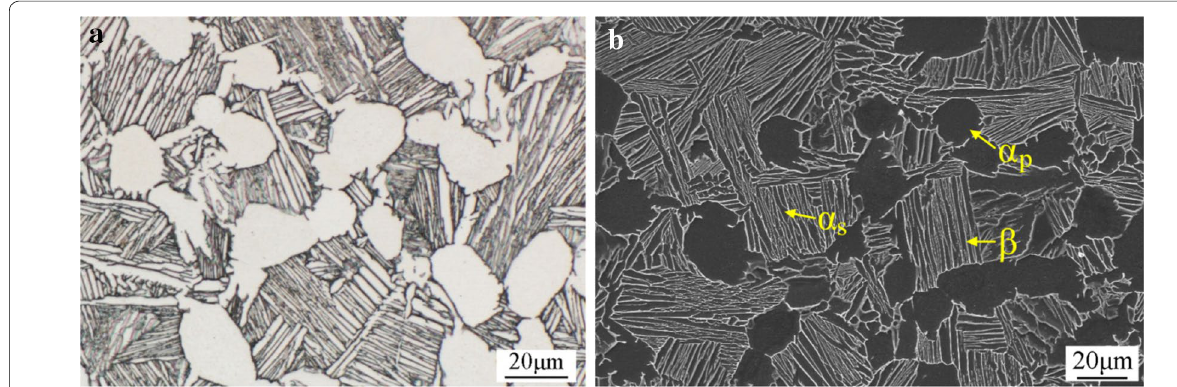
Figure 1 Microstructure of TA19 titanium alloy base metal: ( a ) OM and ( b ) SEM